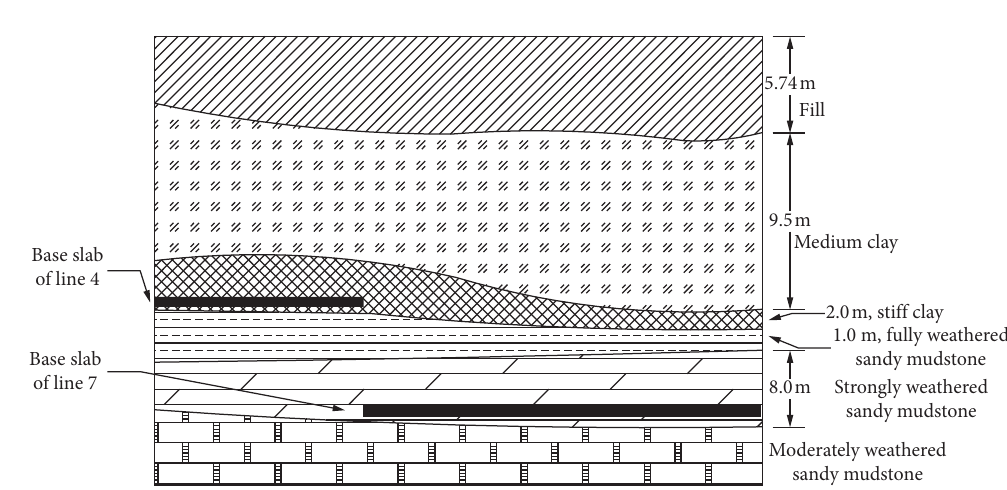
Figure 3: Soil profile of the